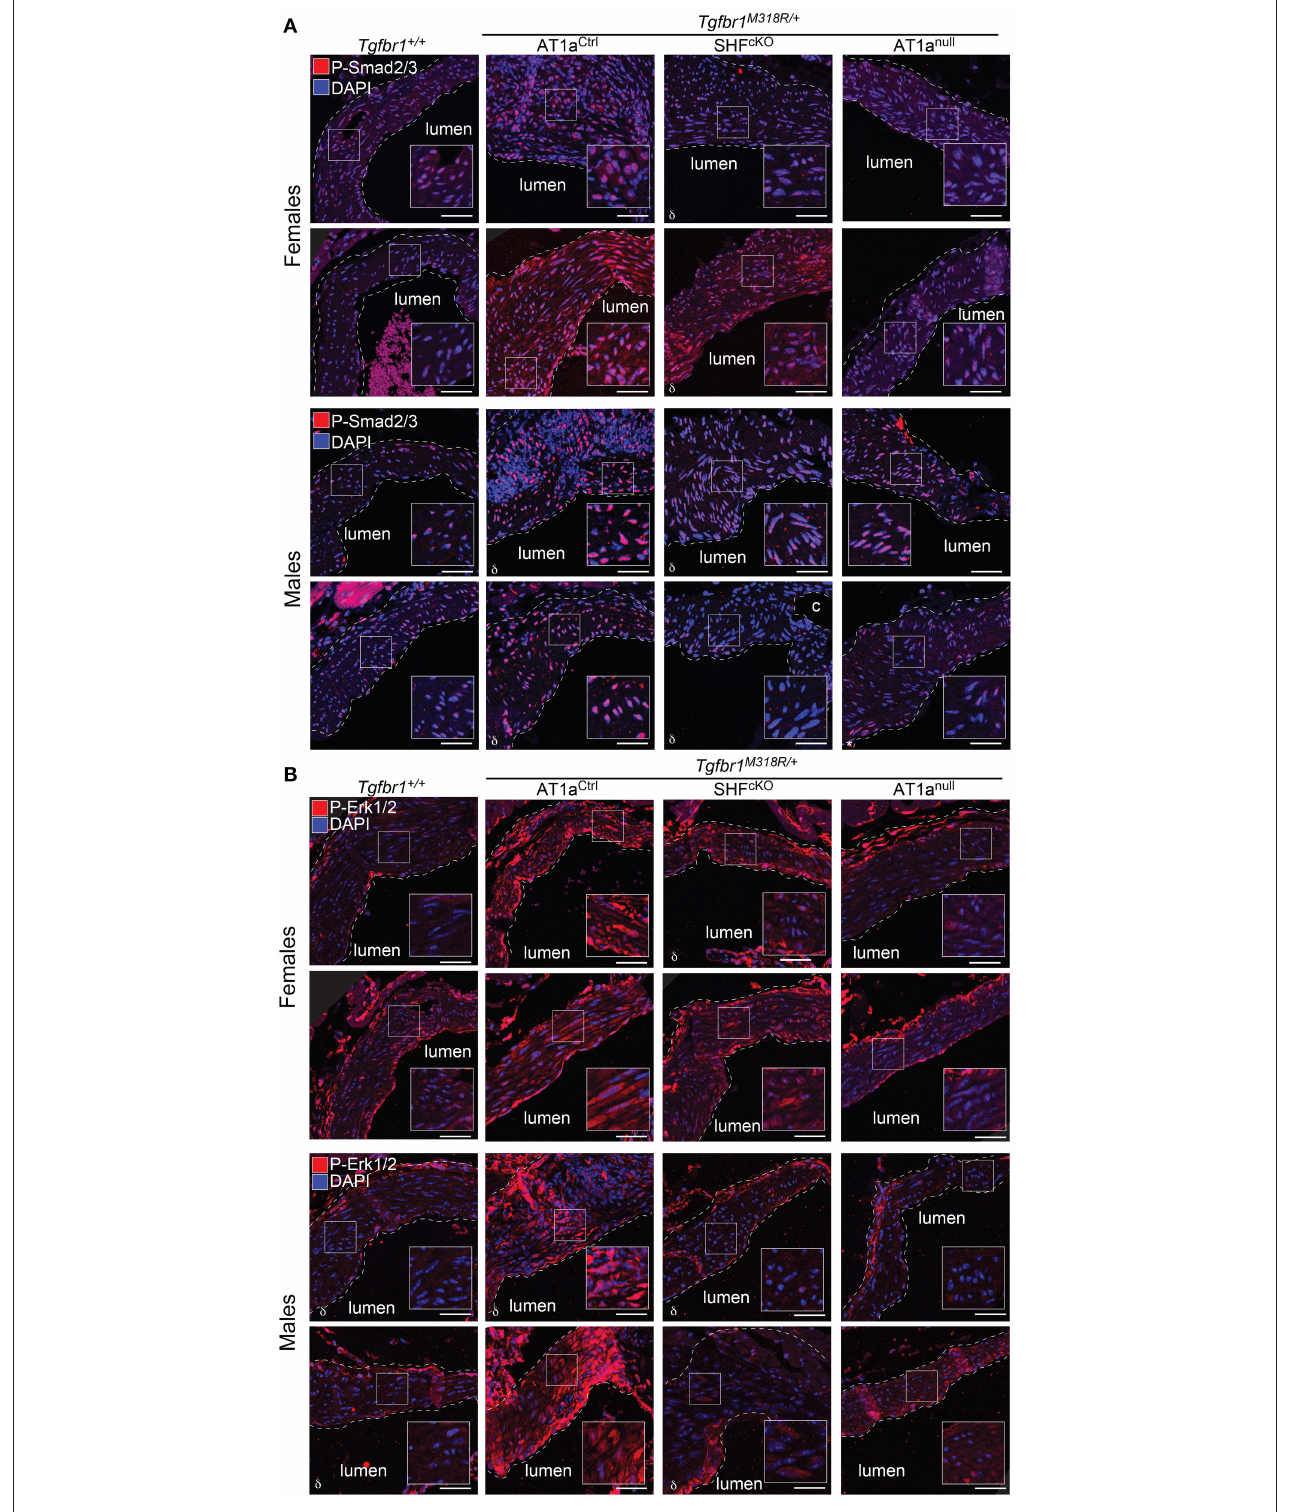
FIGURE 3 | Global and SHF-specific deletion of Agtr1a result in reduced p-Smad2/3 and p-ERK1/2 signaling. Representative images of immunofluorescence for (A) p-Smad2/3 and (B) p-ERK1/2 at 24 weeks of age. Four independent biological replicates are shown per genotype, two from male animals and two from female animals. Insets identify locations shown at higher magnification. Images were acquired at 20 × magnification. Scale bar is 50 µ m. δ symbol in the left-hand corner of a given image indicates the section is from an animal heterozygous for the Agtr1a D null allele.